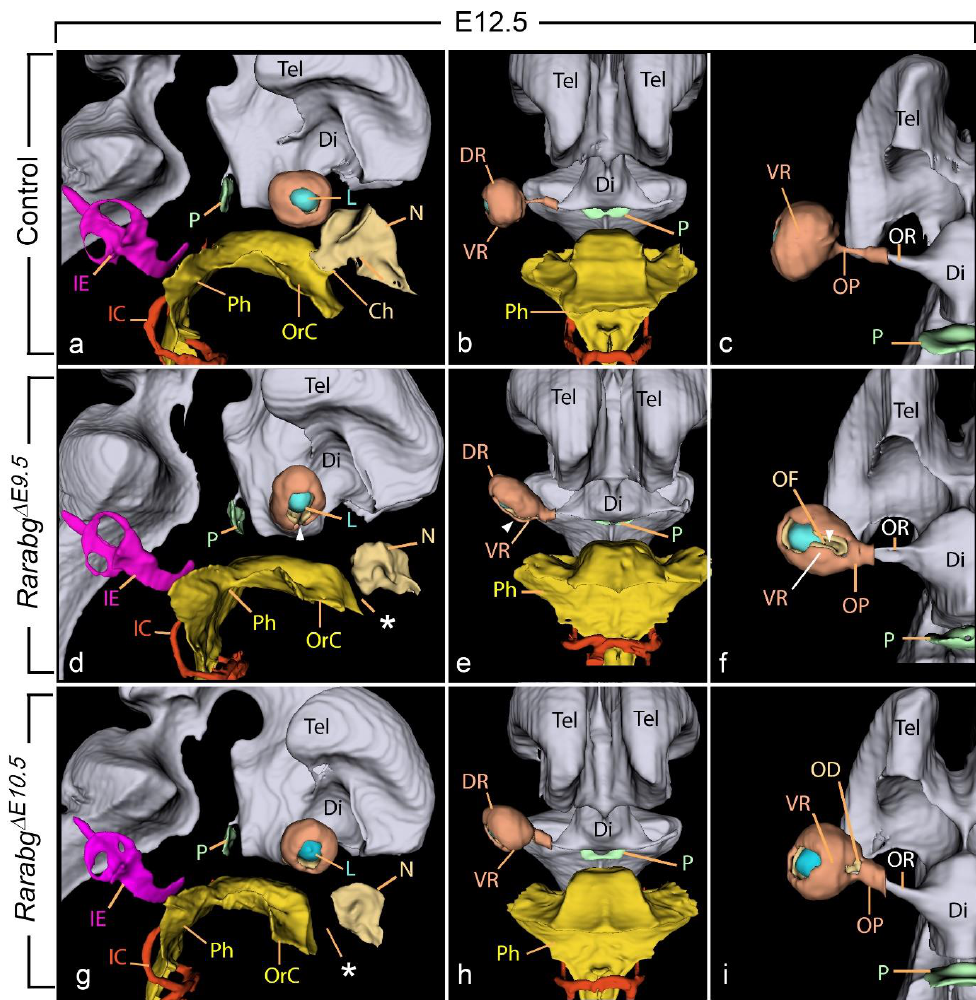
Figure 5. Right lateral views ( a , d , g ), frontal views ( b , e , h ) and ventral views ( c , f , i ) of 3D- reconstructions of the head region in a control embryo ( a – c ), in a Rarabg ΔE9.5 mutant ( d – f ), and in a Rarabg Δ10.5 mutant ( g – i ) at E12.5. The panel focuses: (i) on the anatomy of the optic cup and on its position relative to its neighbouring structures and (ii) on the communications between the nasal and oral cavities (the primitive choanae) in control embryos which is absent in mutant embryos, leading to choanal atresia. Ch, primitive choana; Di, cavity of the diencephalon (3rd ventricle); DR and VR, dorsal and ventral region of the retina, respectively; IC, internal carotid artery; IE, cavities of the inner ear; L, lens; N, nasal cavity; OrC, oral cavity; OD, optic disc; OF, optic fissure; OP, optic peduncle; OR, optic recess of the 3rd ventricle; P, pituitary gland; Ph, pharyngeal cavity; Tel, telencephalic vesicle. The white arrowhead points to the ventral opening in the optic cup (retinal coloboma) and the asterisks indicate the “gap” between the nasal and oral cavities resulting from the absence of the choana. Same magnifications in ( a , d , g ), in ( b , e , h ) and in ( c , f , i